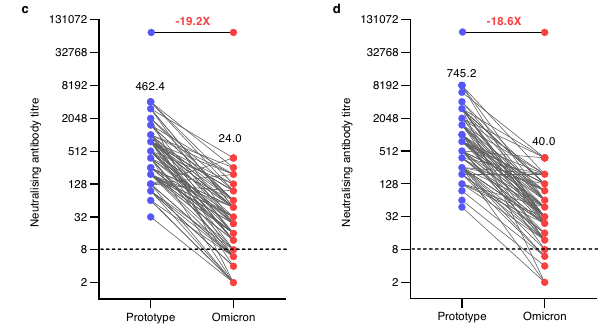
Fig. 4 | Reduction of cross-neutralisation to the Omicron. a Paired neutralising antibody titres against the prototype SARS-COV-2 (blue) and the Omicron (red) in Cohort 1, 1.5 μ g group ( n =85). b Paired neutralising antibody titres against the prototype SARS-COV-2 (blue) and the Omicron (red) in Cohort 1, 3.0 μ g group ( n =85). c Paired neutralising antibody titres against the prototype SARS-COV-2 (blue)andtheOmicron(red)inCohort2,1.5 μ ggroup( n =85). d Pairedneutralising antibody titres against the prototype SARS-COV-2 (blue) and the Omicron (red) in